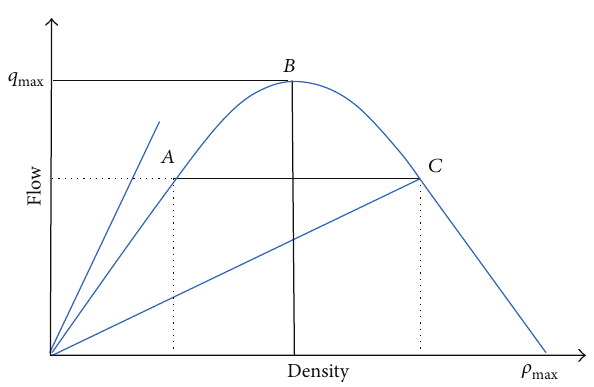
Figure 2: Fundamental diagram.